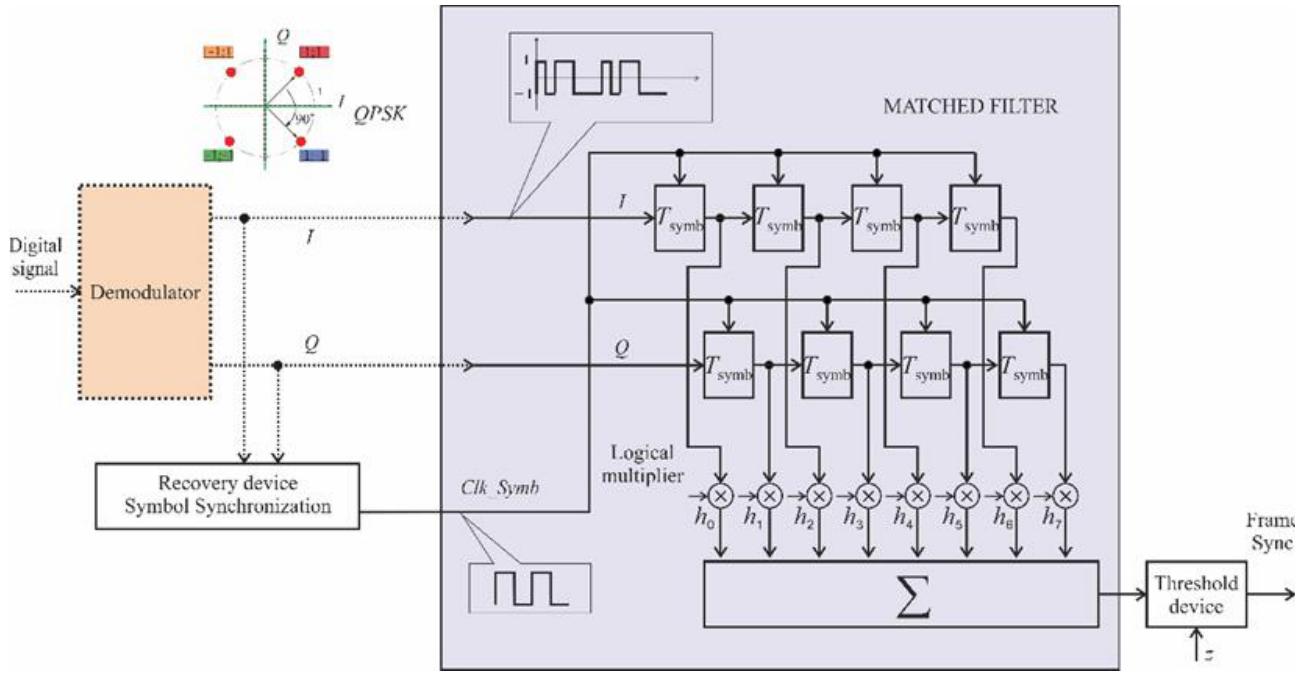
Fig. 8. Structure diagram of the synthesized matched